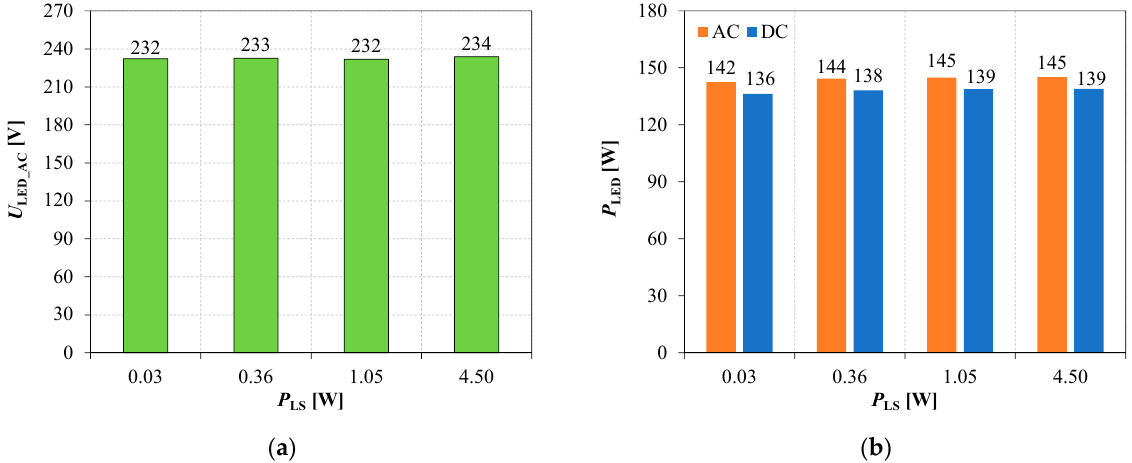
Figure 6. ( a ) The effective AC voltage at the input of the LED driver for various values of the input power driving SJA. ( b ) AC power at the input of the LED driver and DC power at its output for various values of the input power driving SJA.